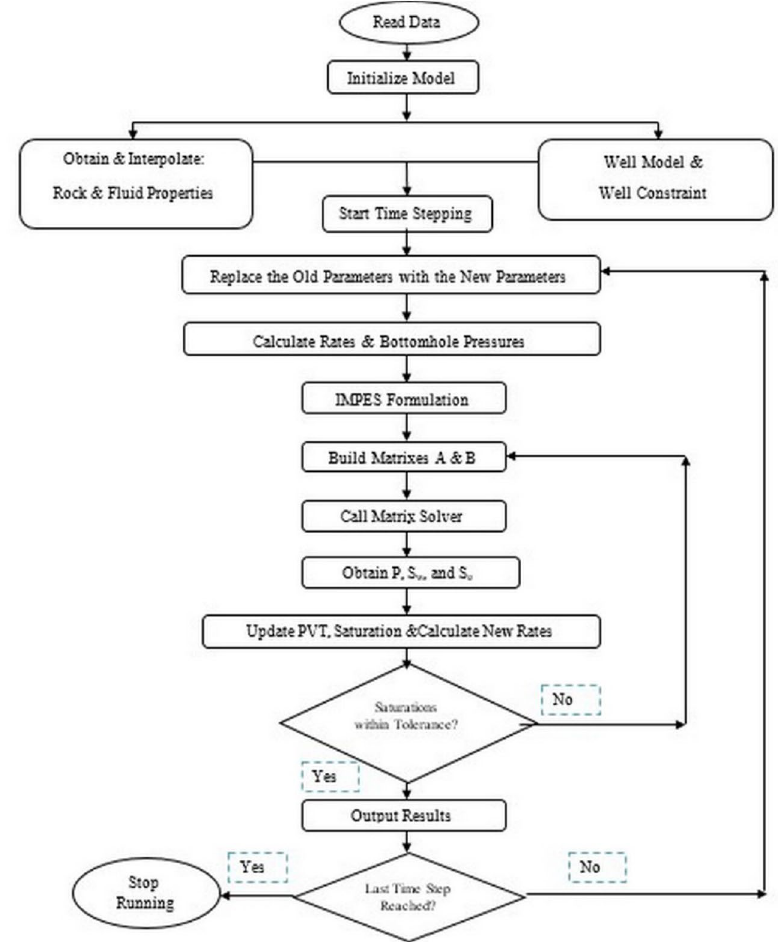
Fig. 3 Simulation